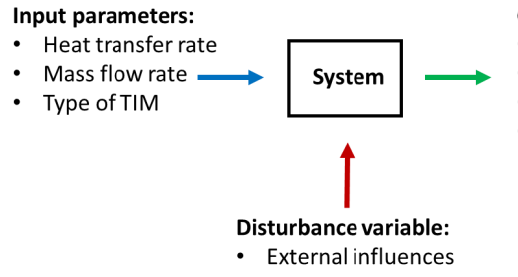
Figure 13. Parameter for DoE.